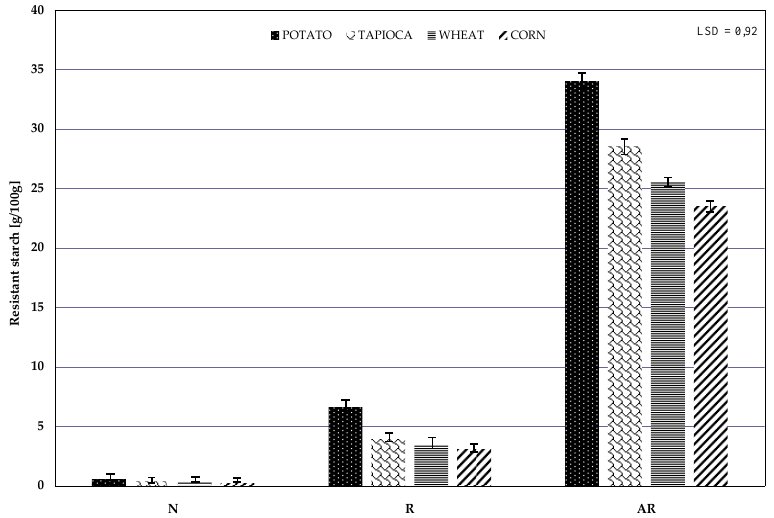
Figure 5. Content of resistant starch in native (N), retrograded ®, and acetylated retrograded (AR) Figure 5 Content of resistant starch in native (N), retrograded ® , and acetylated retrograded (AR) starch of various botanical starch of various botanical origins.